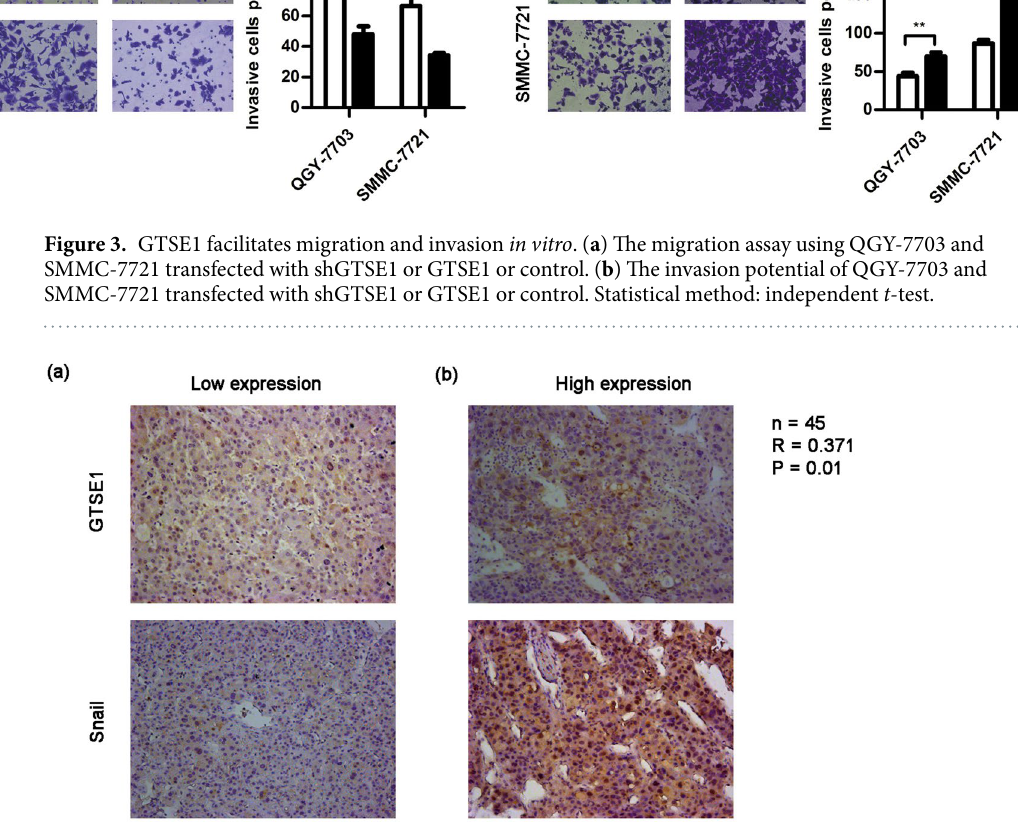
Figure 4. GTSE1 positively correlates with Snail in situ . IHC analysis of GTSE1 and Snail levels in HCC tissues with low ( a ) or high ( b )